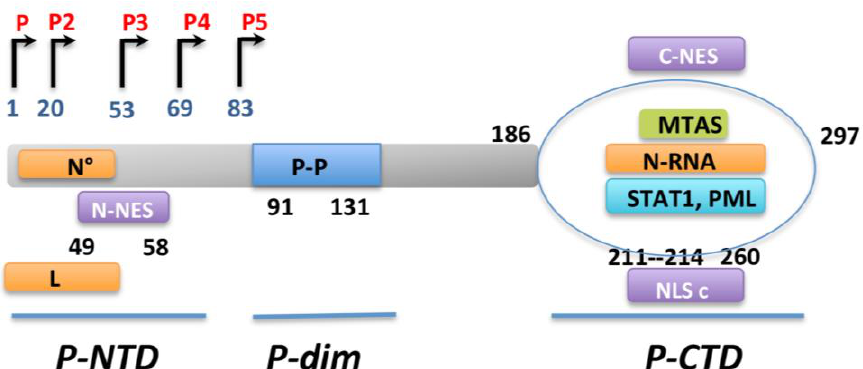
Figure 4. Functional and structural characterization of RABV-P protein. The RABV-P gene encodes a full length (P1) and four N-terminally truncated isoforms (P2-P5) from the initial and subsequent internal, in frame Met codons at indicated residues. RABV-P protein contains three functional domains separated by two intrinsically disordered regions: the N-terminal domain ( P-NTD , residues 1 to 52), interacting with the soluble N protein (called N°) and L protein; the dimerization domain ( Pdim , residues 91 to 131); and the C-terminal domain ( P-CTD , residues 186 to 297), involved in binding to the N-RNA, as well as cellular proteins STAT1 and PML. The P protein also contains several targeting sequences including two NESs, a conformational NLSc, formed by the globular fold of the CTD.